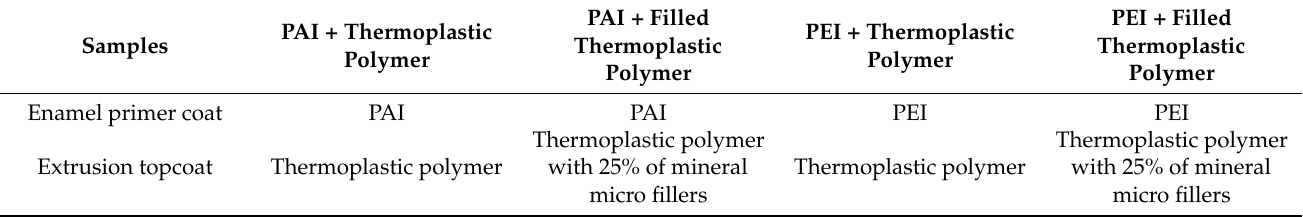
Table 1. Basics characterizations of polymers enameled with thermoplastic on extrusion layer.